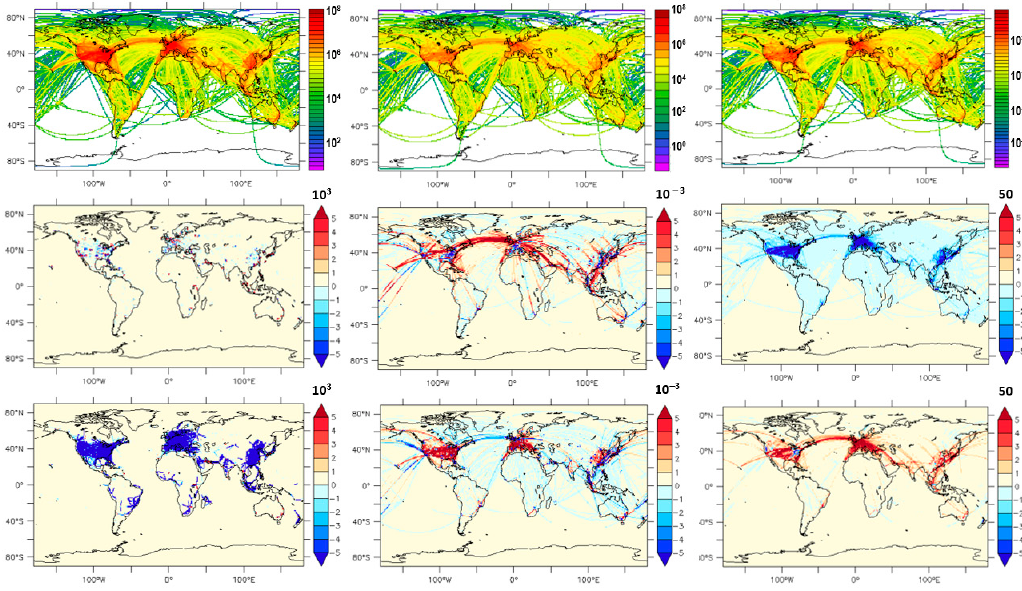
Figure 1. Global distribution of distance flown ( left ), nitrogen oxides ( middle ) and soot emission ( right ): reference case absolute emissions [kg] (upper row), and difference between inventories Flying Higher (middle row) and Flying Lower (lower row) compared to reference case.